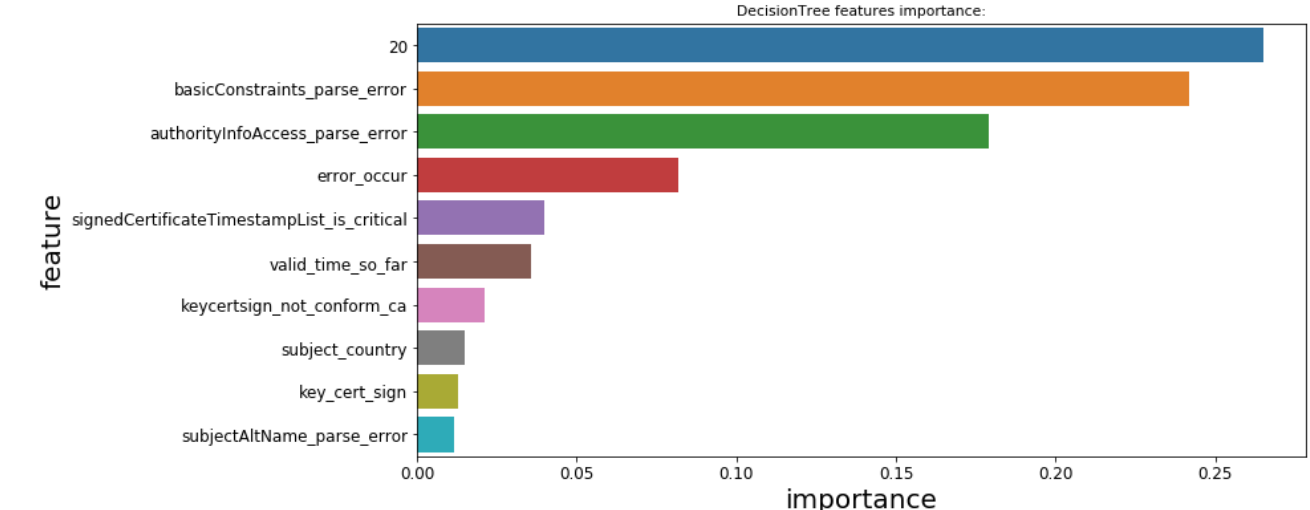
Figure 7. Important features of CatBoost.